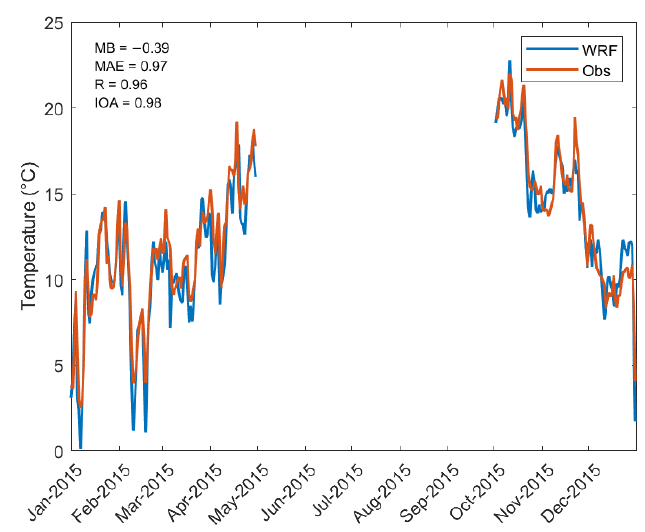
Figure 2 . Observed and modeled time series of mean daily air temperature (°C) during the cold Figure 2. Observed and modeled time series of mean daily air temperature ( ◦ C) during the cold period of 2015, averaged over all stations. period of 2015, averaged over all